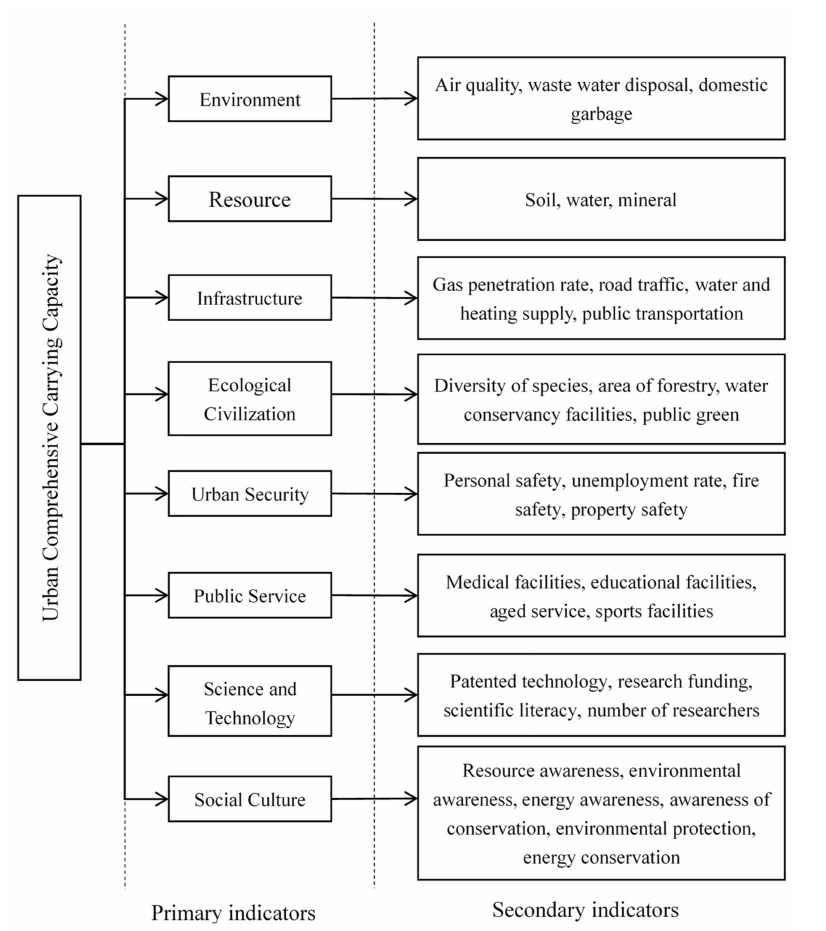
Figure 2. Indicator library for the evaluation of urban comprehensive carrying